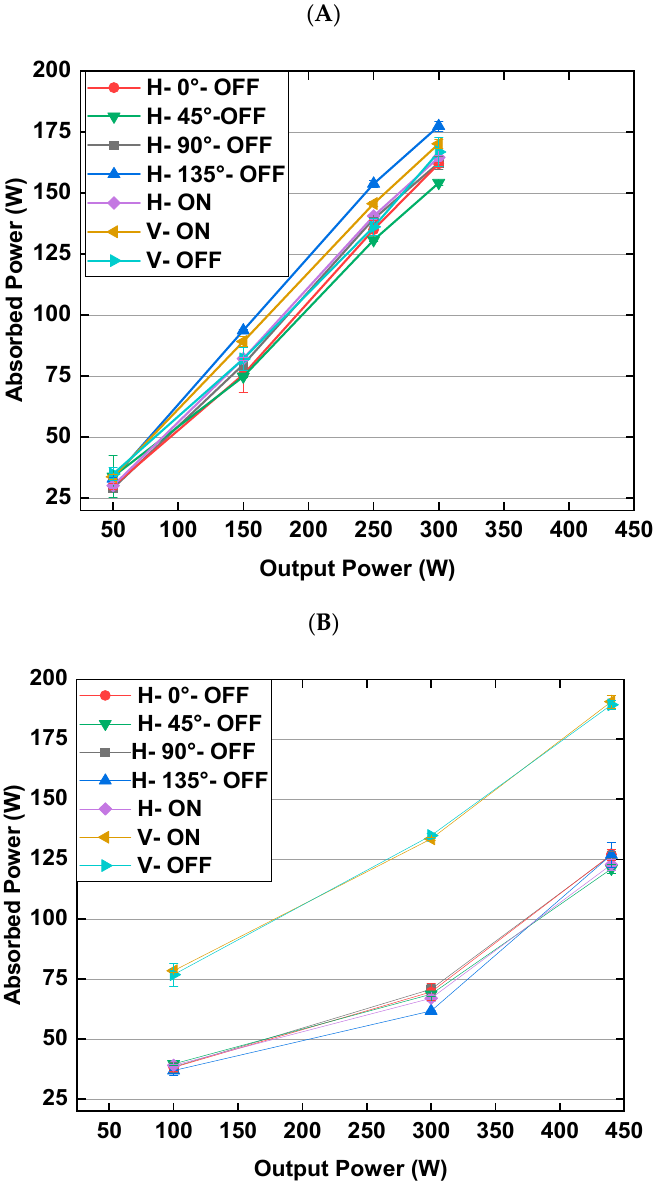
Figure 6. Correlation between absorbed and output powers for different sample orientations in ( A ) the solid-state microwave system and ( B ) magnetron microwave system.